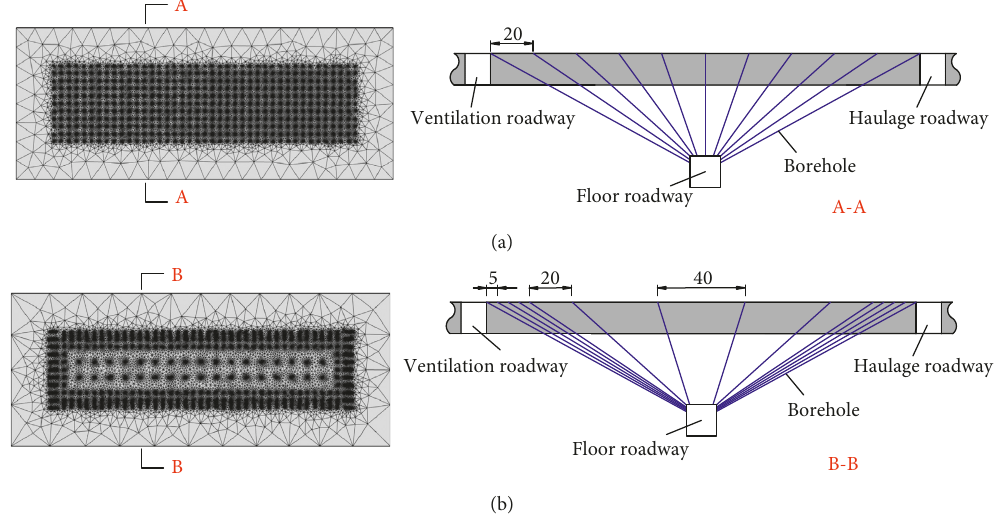
Figure 6: Drilling arrangement schemes for gas extraction. (a) Original arrangement. (b) Optimized arrangement.